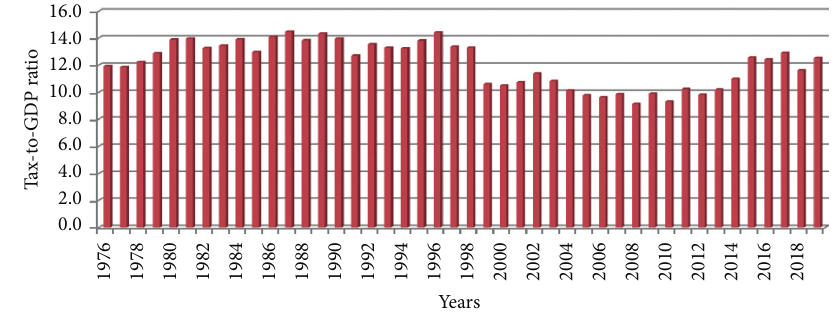
Figure 1: Tax-to-GDP